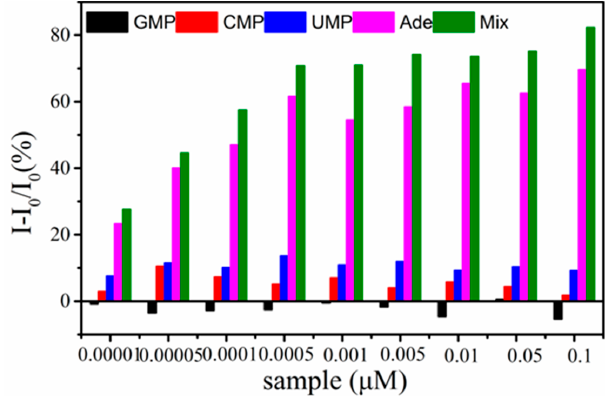
Figure 6. The fluorescent response of the proposed aptasensor towards adenosine and the three analogues: guanosine, uridine and cytidine, and the mixture of adenosine with the analogues. The concentration of all samples were 0.00001, 0.00005, 0.0001, 0.0005, 0.001, 0.005, 0.01, 0.05, and 0.1 μ M.